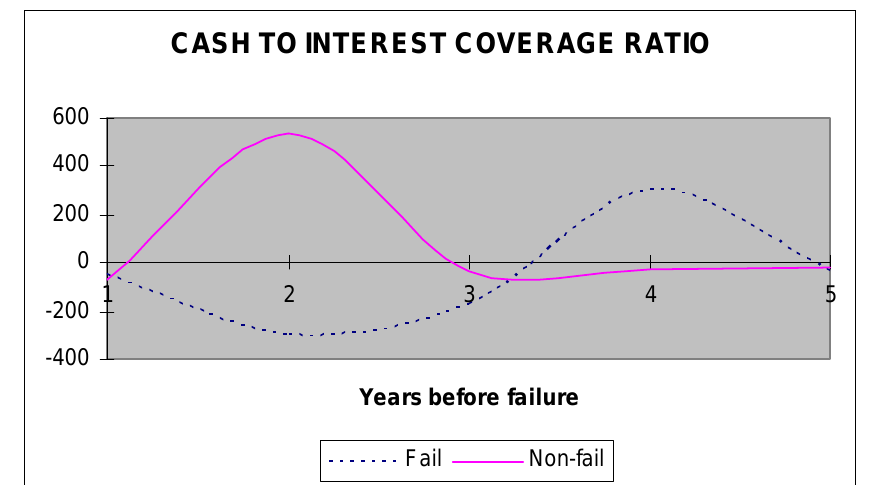
Figure 6: Cash interest coverage ratio CASH TO INTEREST COVERAGE RATIO